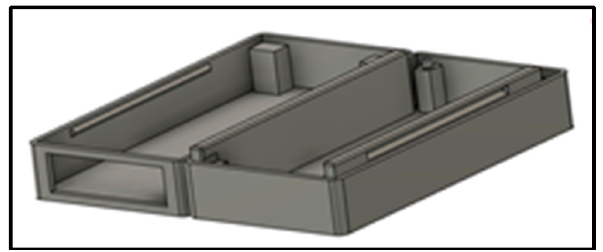
Figure 15. Snap case design for ease of access to the sensor. Figure 14. Cutouts for mounting and sensor accessibility.